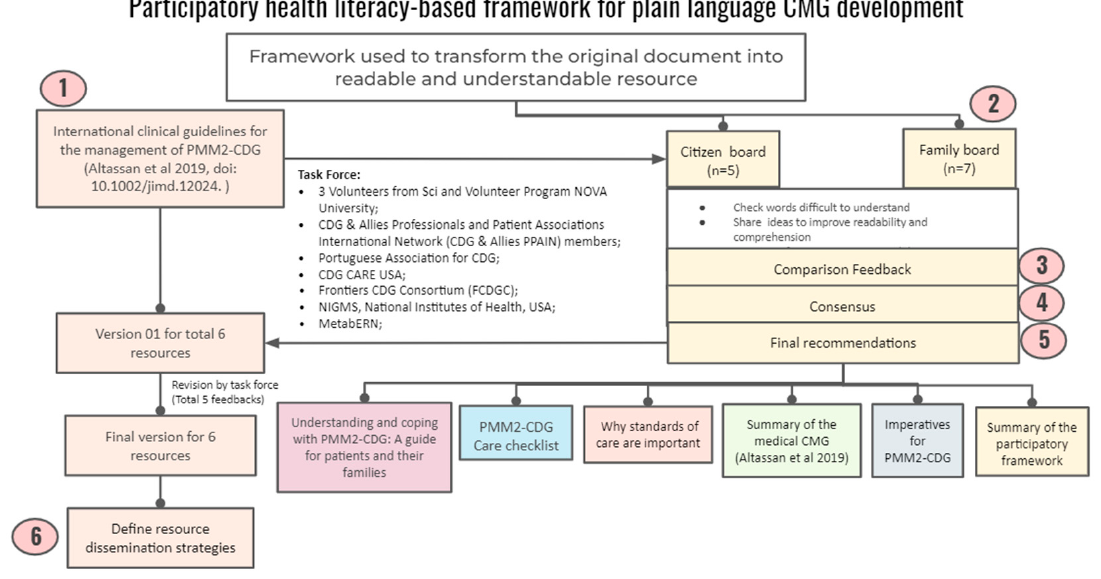
Figure 2. Framework for developing plain CMGs based on CDG community’s needs/preferences and health literacy principles.